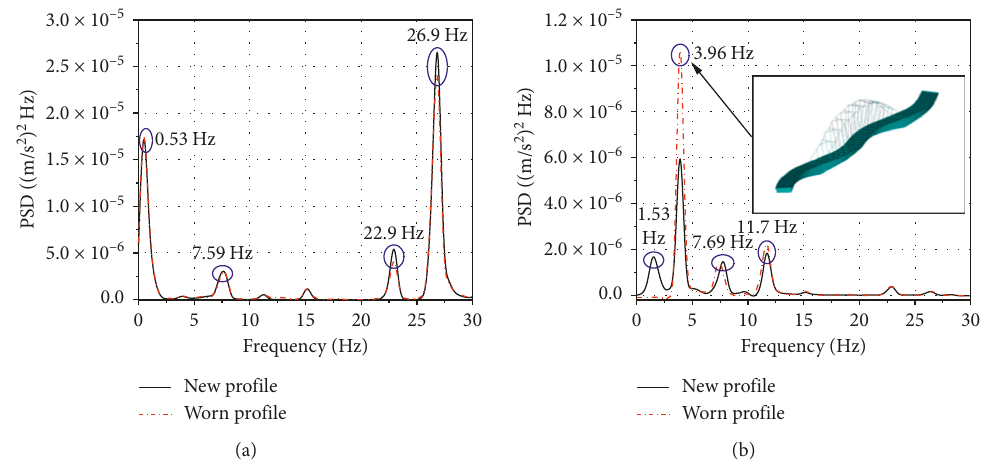
Figure 25: PSD analysis of bridge accelerations of the main span: (a) vertical; (b) lateral.